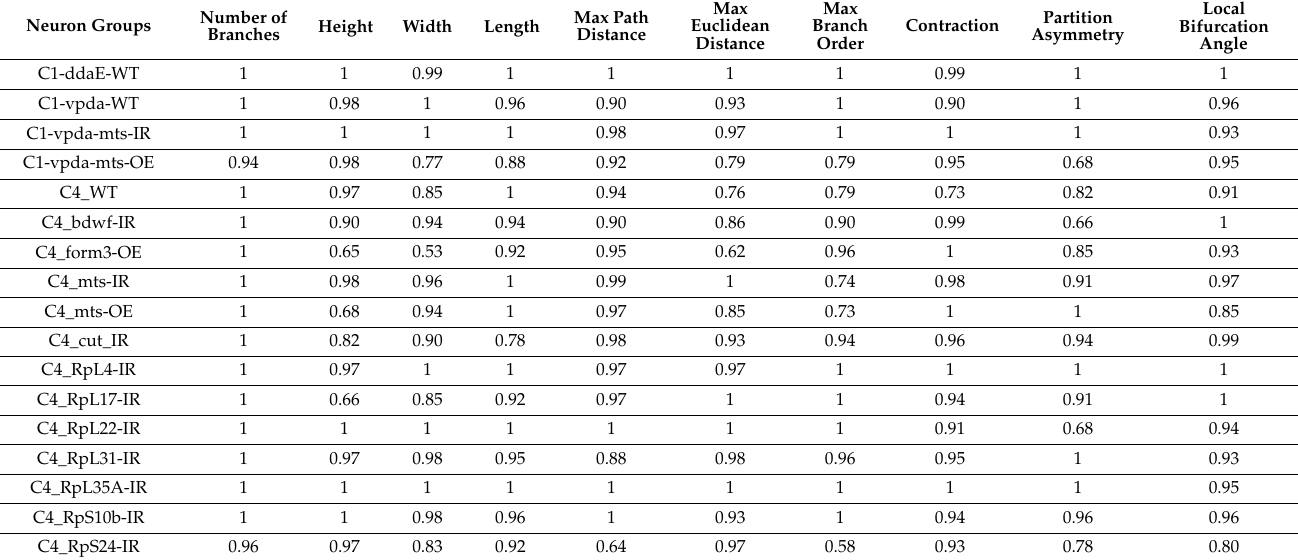
Table 3. False Discovery Rate-corrected t -test or Wilcoxon test p values of comparisons for 10 L-Measure morphometrics between real and simulated neuron across 17 cell